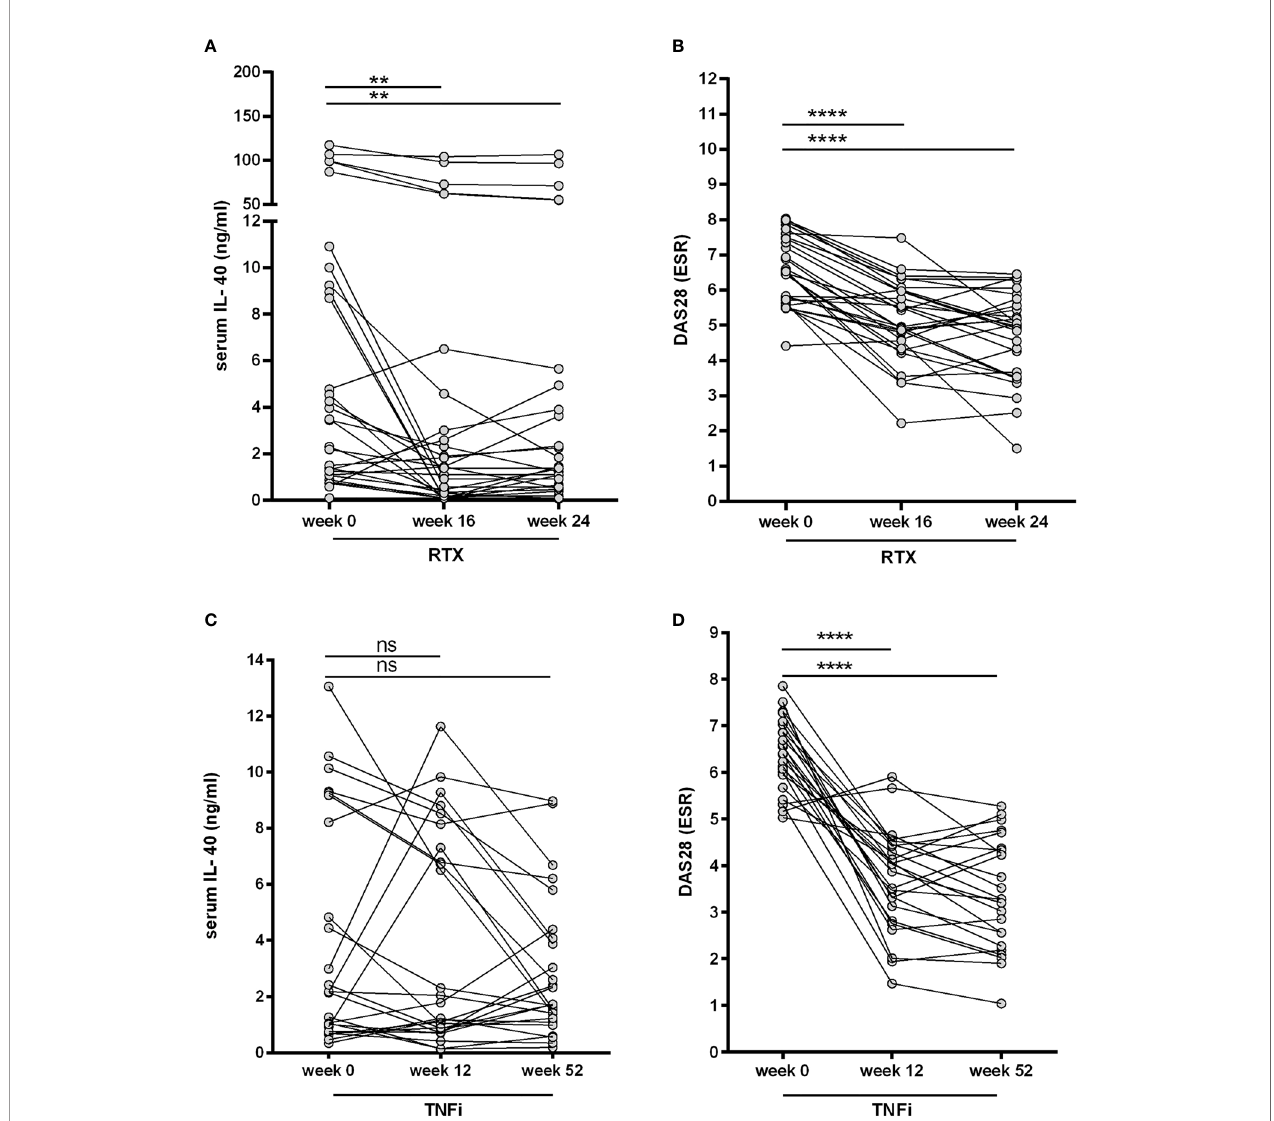
FIGURE 4 | Effect of biological therapies on the serum IL-40 in patients with rheumatoid arthritis (RA). A decrease in IL-40 serum levels (A) was observed after the fi rst series of rituximab (RTX) at weeks 16 and 24 and was associated with a drop in the disease activity (DAS28) (B) . No signi fi cant changes of IL-40 serum levels following therapy with TNF inhibitors (TNFi) after 12 and 52 weeks were detected (C) , even though disease activity (DAS28) markedly declined (D) . **p < 0.01; ****p < 0.0001; ns, nonsigni fi